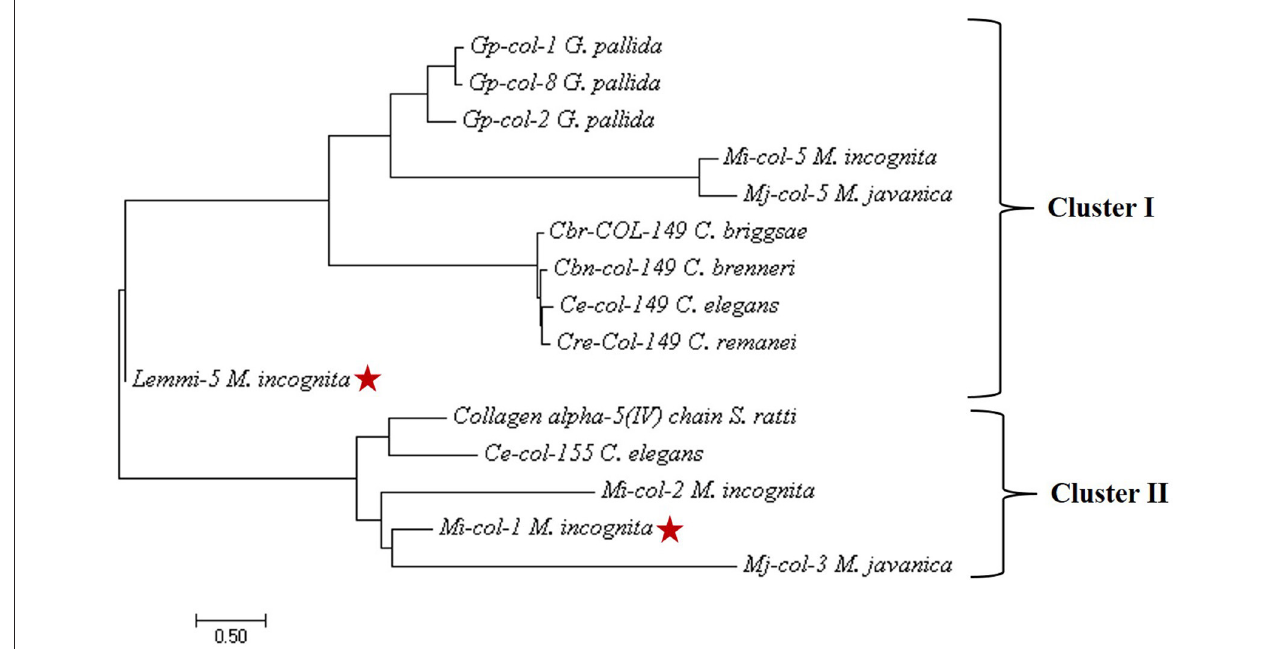
FIGURE 1 | Phylogenetic tree constructed by maximum likelihood method using MEGA 7 showing evolutionary relationship of Mi-col-1 and Lemmi-5 with cuticle collagens of other plant parasitic, animal parasitic and free living nematodes.